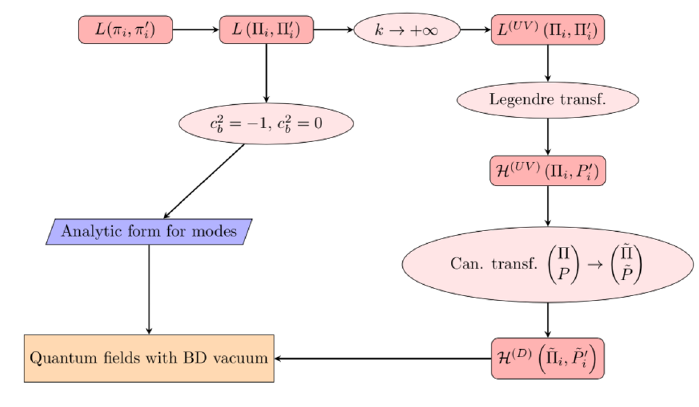
Figure 1. Schematic procedure for